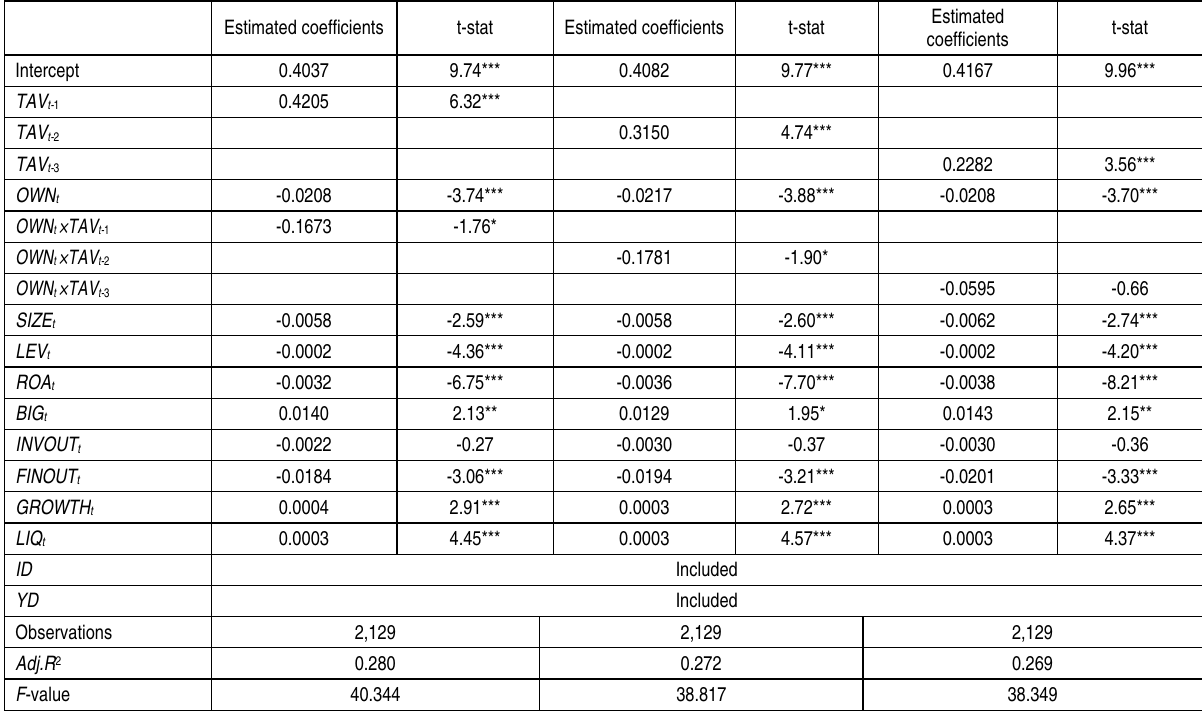
Table 5. Regression Results on Hypothesis